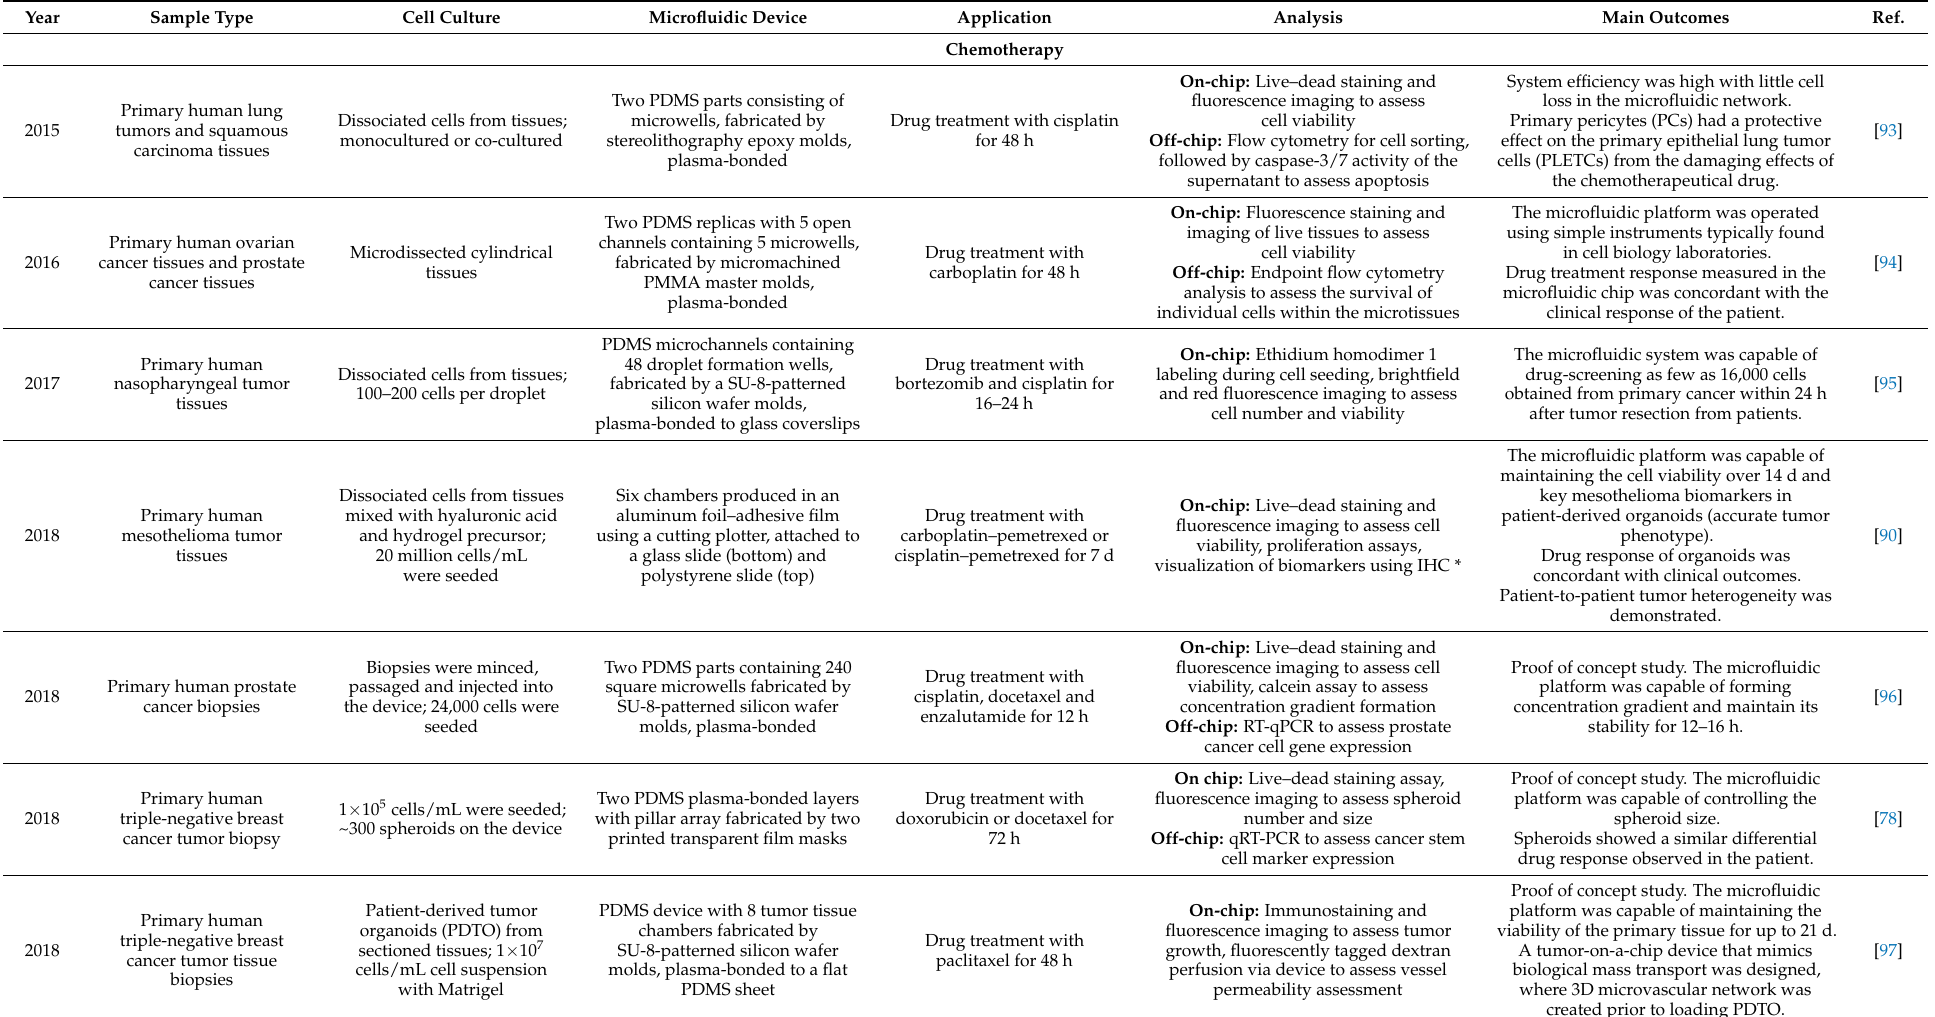
Table 2. Tumor-on-chip models incorporating patient-derived samples for therapy